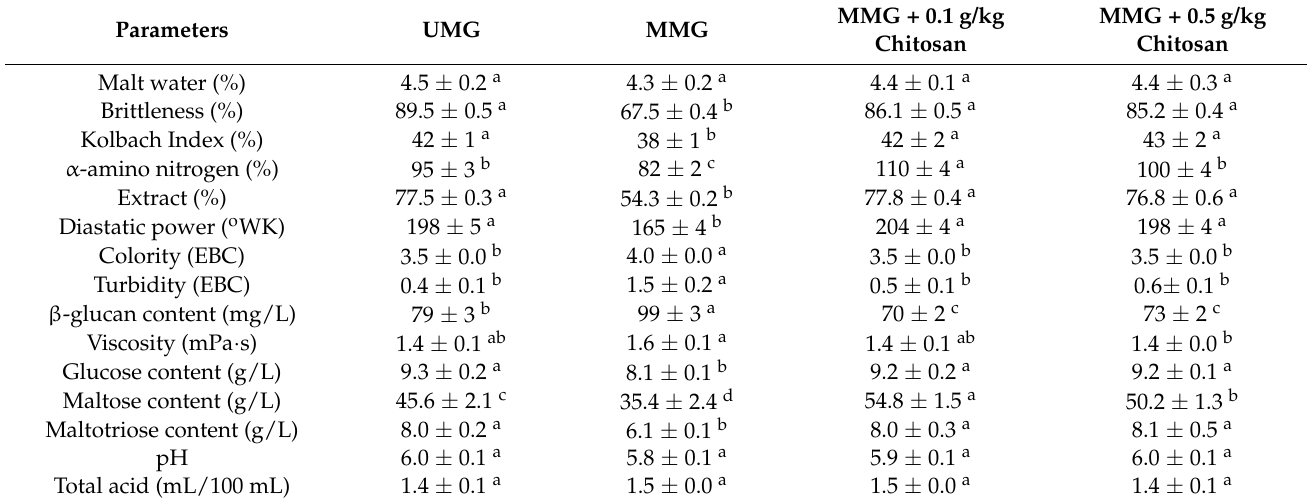
Table 2. The quality parameters of uninfected malt grains (UMG), mixed malt grains (MMG) and MMG treated with 0.1 g/kg or 0.5 g/kg of chitosan (102.7 kDa) in the first steeping